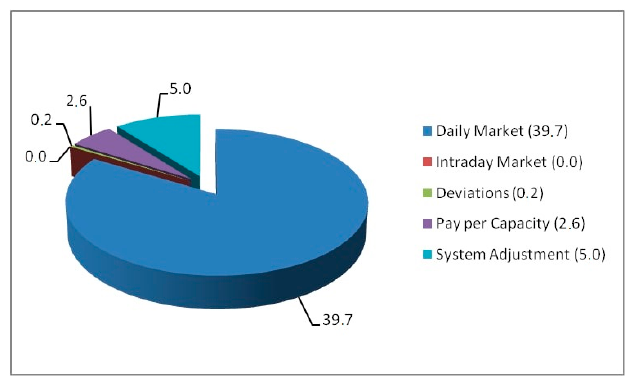
Figure 4. Components of the Average Final Price in 2016, price for 1 MWh in euros.